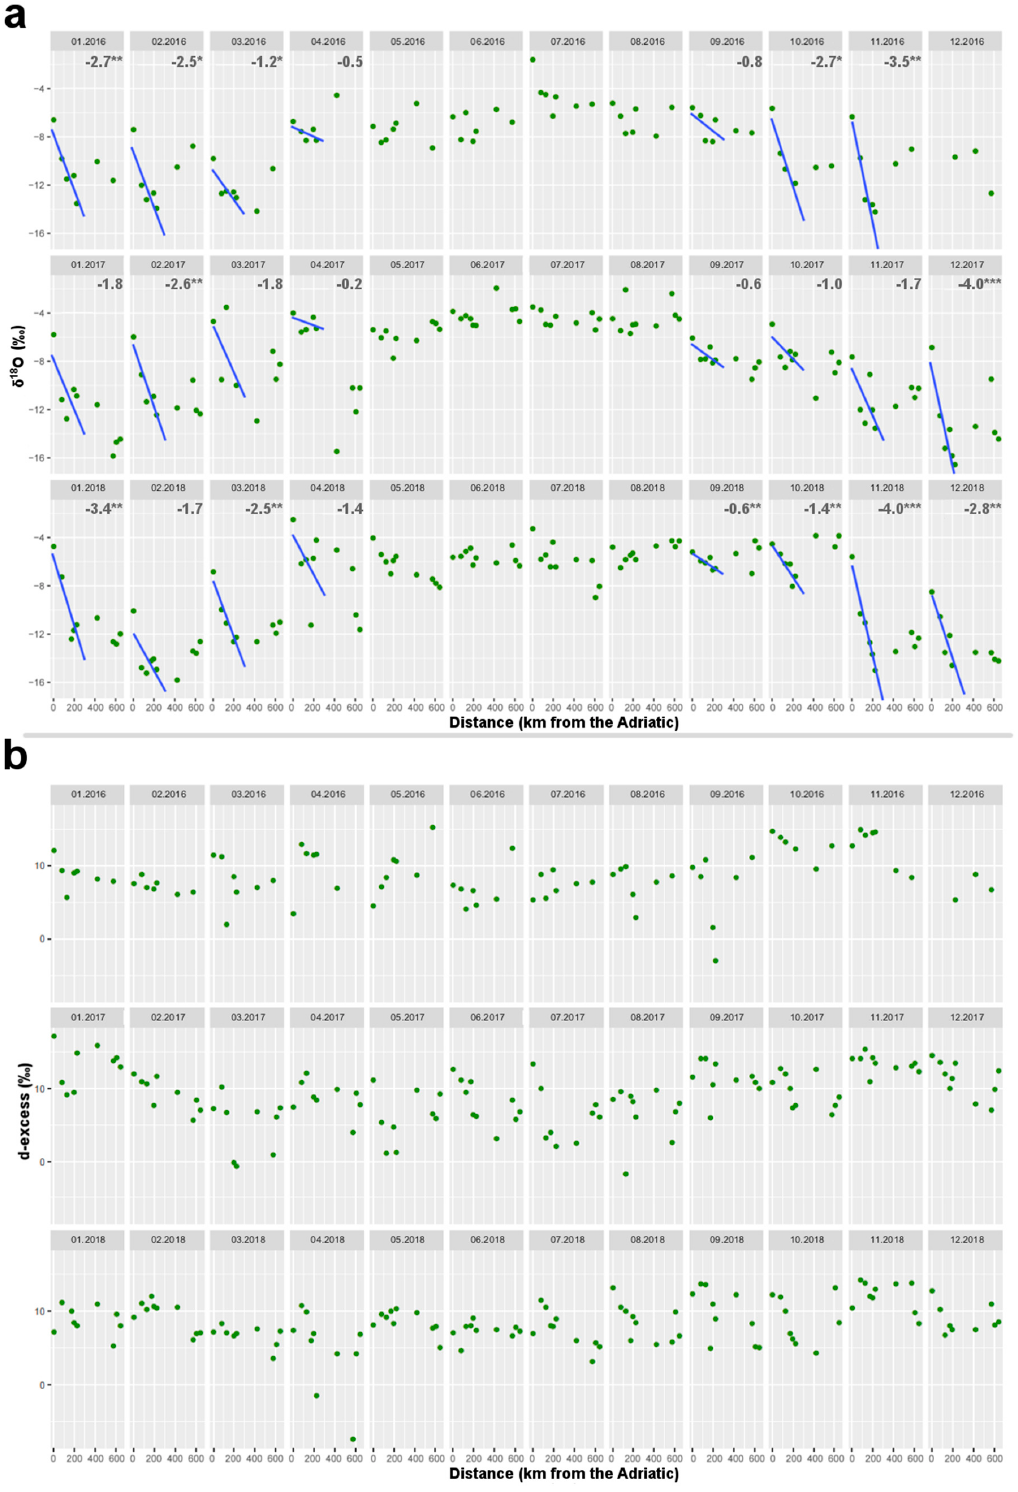
Figure 4. Stable isotope characteristics of monthly precipitation from the Adriatic coast to the northeastern corner of the Great Hungarian Plain: δ 18 O ( a ) and deuterium excess (d-excess) ( b ) vs. distance from the Adriatic coast. Best fit lines (blue) for precipitation δ 18 O data and distance are plotted over the first half of the continental transect. The significance of the linear fit is coded as α -values of 0.01, 0.05 or 0.1 that are marked with (***), (**) or (*), respectively.